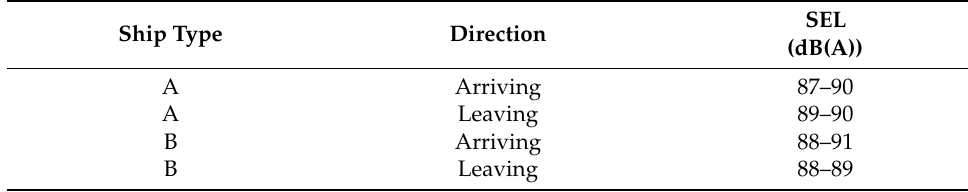
Table 10. A-weighted SEL of seagoing ships, as reported in